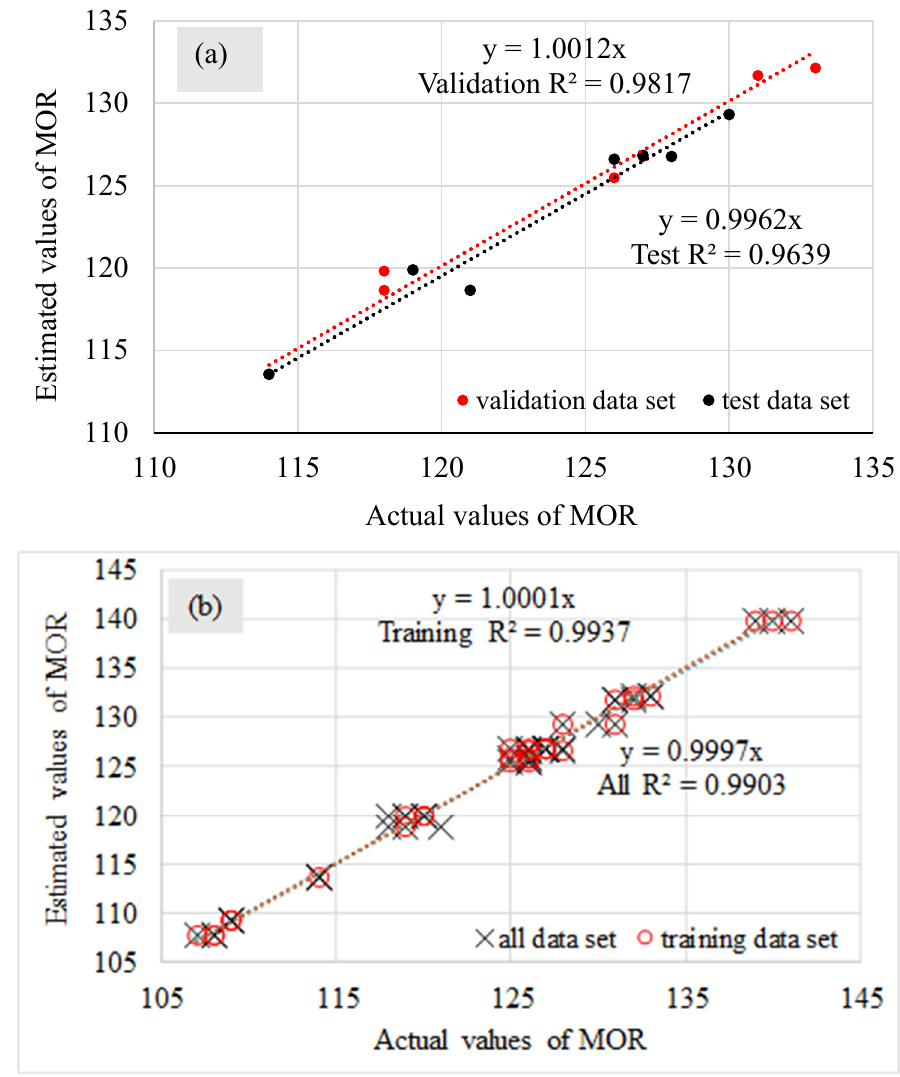
Figure 4. The regression curve of validation and test ( a ) and training and all ( b ) data sets.